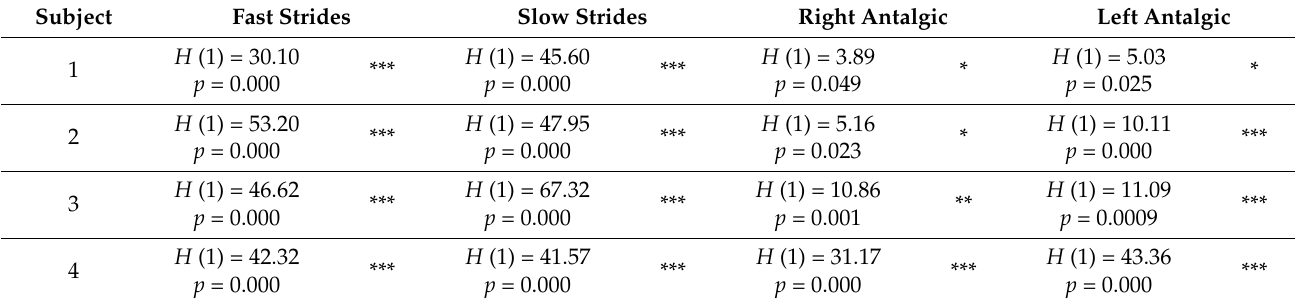
Table 11. Detection of Abnormal or Irregular Strides using Cadence [steps/minute] (Kruskal–Wallis